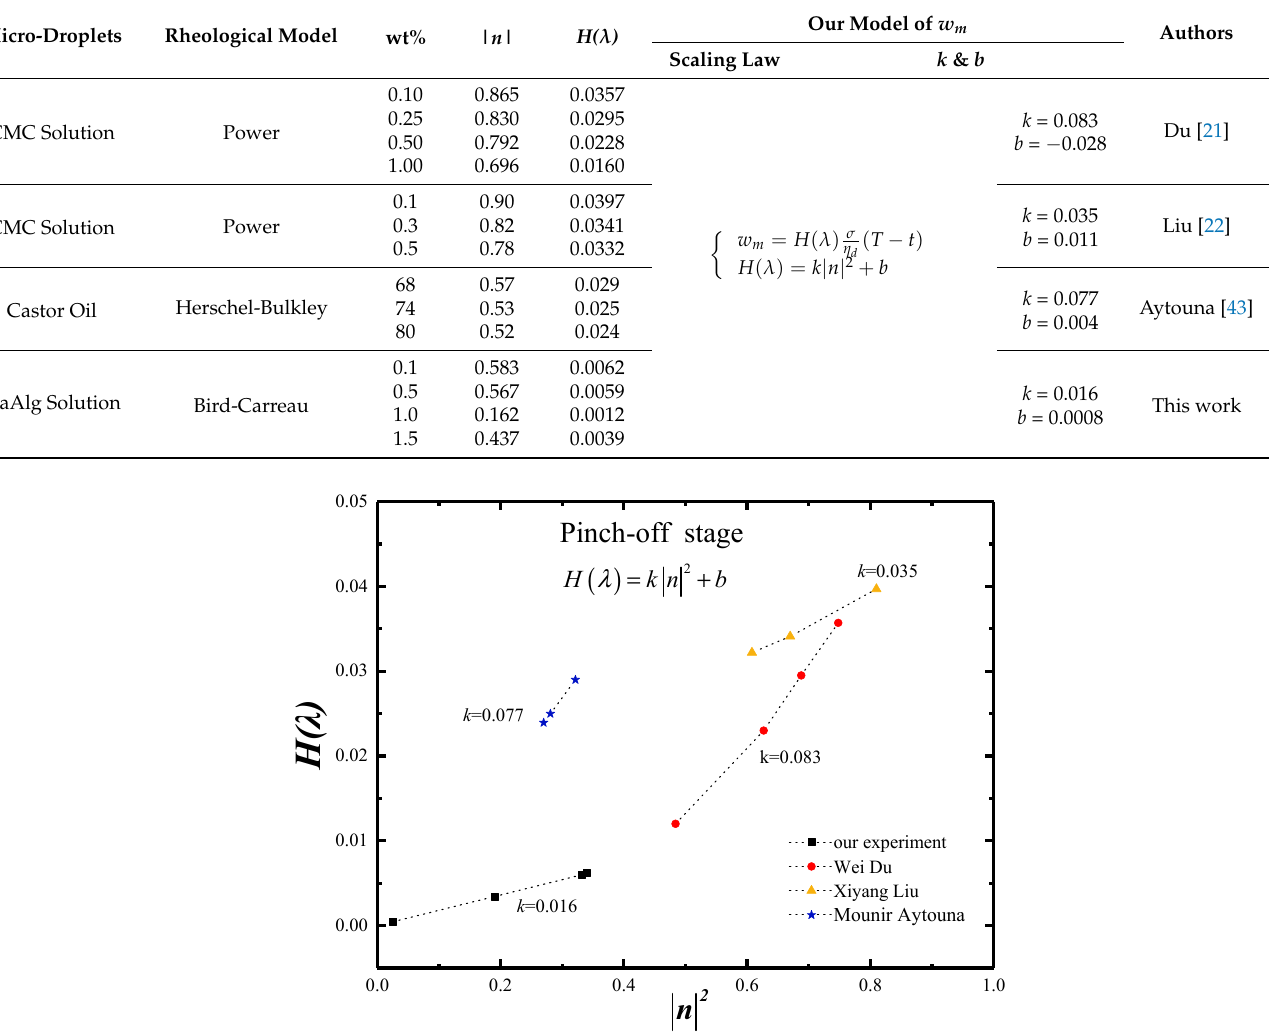
Table 4. The normalization model of minimum neck width w m in the pinch-off stage.